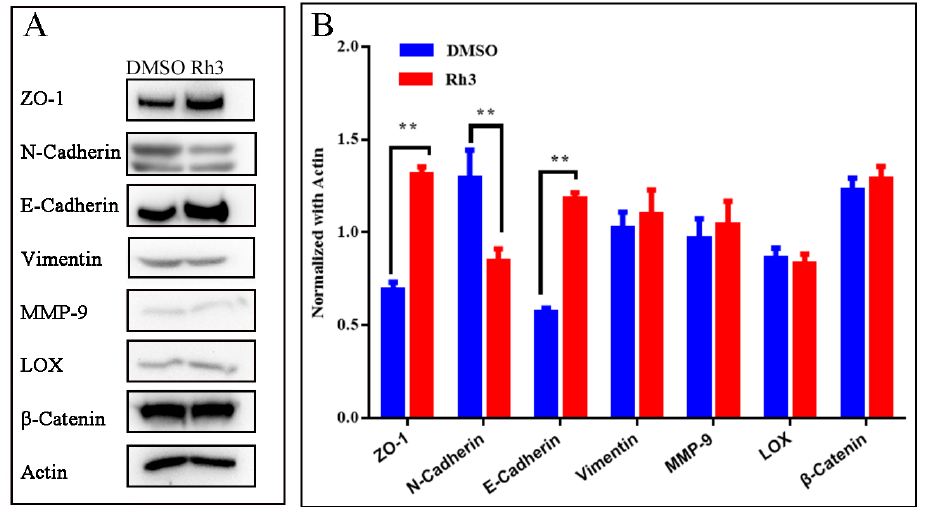
Figure 4. Effect of Rh3 on the expression of invasion and migration associated proteins. (A): Expression of ZO-1, N-Cadherin, E-Cadherin, Vimentin, MMP-9, β -Catenin, and LOX in HCT116 cells were detected by Western blotting with actin as the loading control. ( B ): Gray analysis of western blotting on ZO-1, N-Cadherin, E-Cadherin, Vimentin, MMP-9, LOX, and β -Catenin. Groups were compared using a two-tailed Student’s t -test. ** p < 0.01.